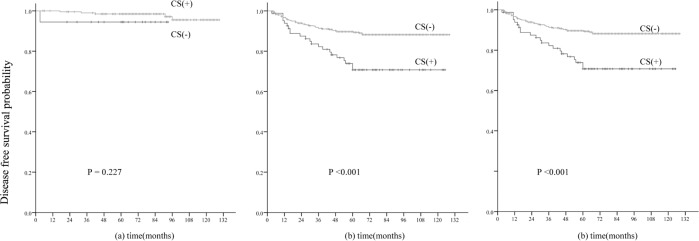
Distant metastasis-free survival curves for all 1087 patients with NPC with and without cavernoussinus invasion (CSI) stratified by regional lymph node metastasis.(a)Group 1: N0 disease; (b) Group 2: N1 disease;(c)Group 3: N2-N3 disease.